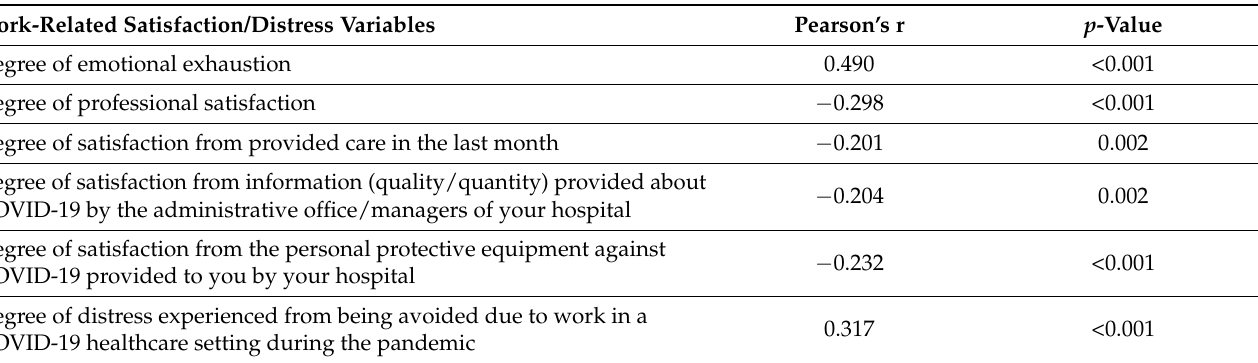
Table 4. The correlation analysis between total STSS-M score and work-related satisfaction/distress variables (Pearson’s r; N =